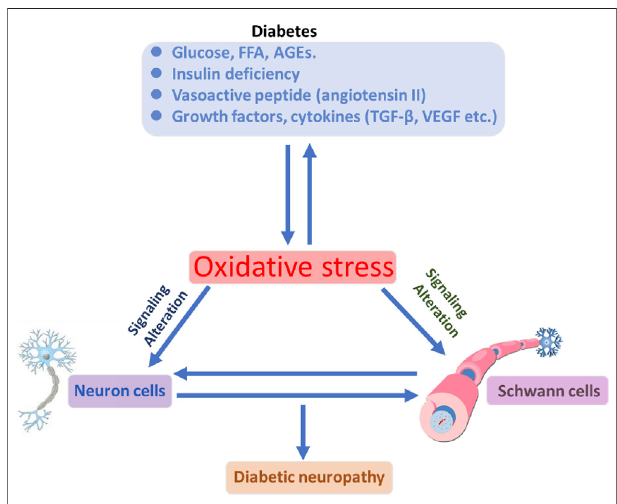
FIGURE 5 | Mechanisms of oxidative stress-induced DNP in injured neuronal